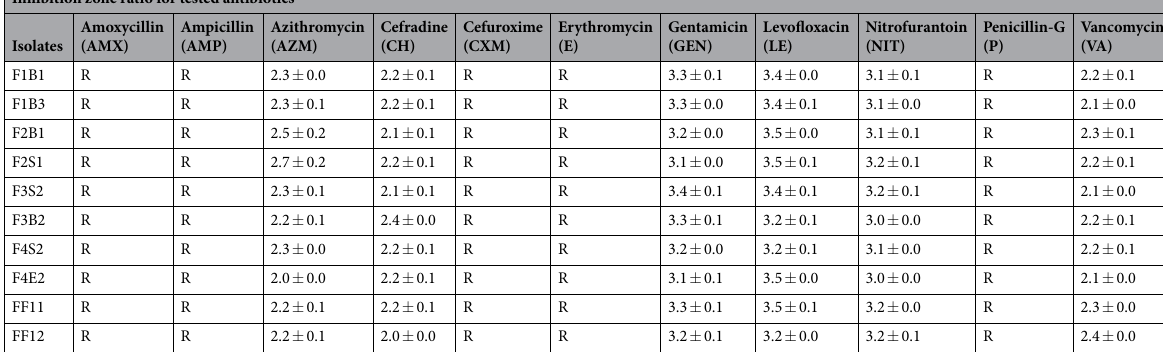
Table 2. Antibiotic susceptibility profile of fish pathogenic E . faecalis isolates from infected fishes in